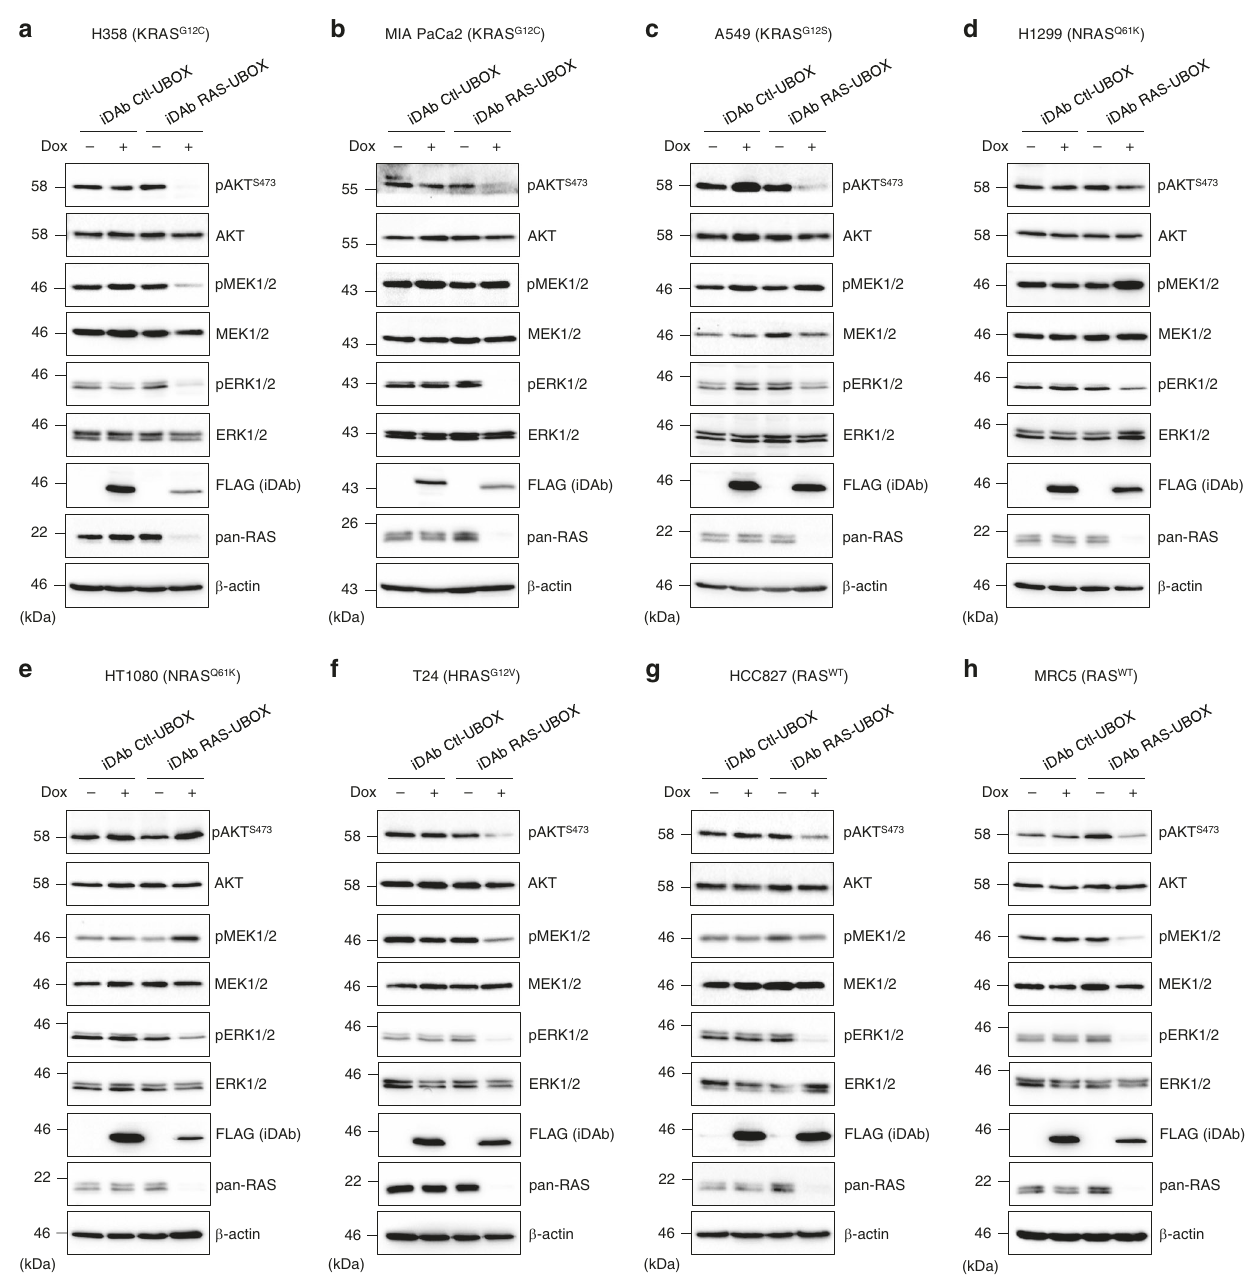
Fig. 4 The pan-RAS degrader inhibits RAS signalling pathways in all cell lines. Effect of the pan-RAS degrader on RAS downstream signalling pathways of various cell lines was examined by Western blot analysis: a H358 (KRAS G12C ), b MIA PaCa-2 (KRAS G12C ), c A549 (KRAS G12S ), d H1299 (NRAS Q61K ), e HT1080 (NRAS Q61K ), f T24 (HRAS G12V ), g HCC827 (RAS WT ) and h MRC5 (RAS WT ). All the cell lines stably express dox inducible iDAb RAS-UBOX or its negative control iDAb Ctl-UBOX. FLAG antibody is used to determine iDAbs expression when induced with 0.2 μ g.mL − 1 of doxycycline for 72 h ( + ) or not induced ( − ). β -actin is the loading control. Each experiment was performed at least three times. a – h Source data are provided as a Source Data fi compared to the parental DARPin. We assessed the effect of modify the proliferation of cancer cell lines with mutant NRAS or KRAS or pan-RAS degradation on the proliferation of our panel HRAS (Fig. 6d – f) nor of the RAS WT cells HCC827 and MRC5 of cell lines with inducible macrodrugs by testing the proliferation (Fig. 6g, h). These data concur with the effect of the KRAS in 2D-adherent and 3D spheroid assays. The pan-RAS degrader degrader described on RAS signalling pathways in Fig. 5. On the inhibited proliferation of all the cell lines, in both 2D-adherent or contrary, the parental DARPin KRAS-GFP 2 , like the pan-RAS 3D spheroid assays (Fig. 6a – h) including MRC5 which is non- iDAb-GFP 2 and the pan-RAS degrader, decreased the 2D- adherent proliferation of all the stable cell lines (Fig. 6, Supple- transformed and has wild-type RAS. This was also observed with mentary Fig. 8a – h), endorsing the bene fi t of engineering the the parental iDAb RAS-GFP 2 in 2D-adherent proliferation assays (Supplementary Fig. 8a – h). The KRAS degrader speci fi cally DARPin KRAS into a KRAS-speci fi c degrader. reduced proliferation of cells with mutant KRAS expression in The pan-RAS and the KRAS degraders both inhibited 2D-adherent and 3D spheroid assays (Fig. 6a – c) but did not proliferation in H358 cells by inducing programmed cell death